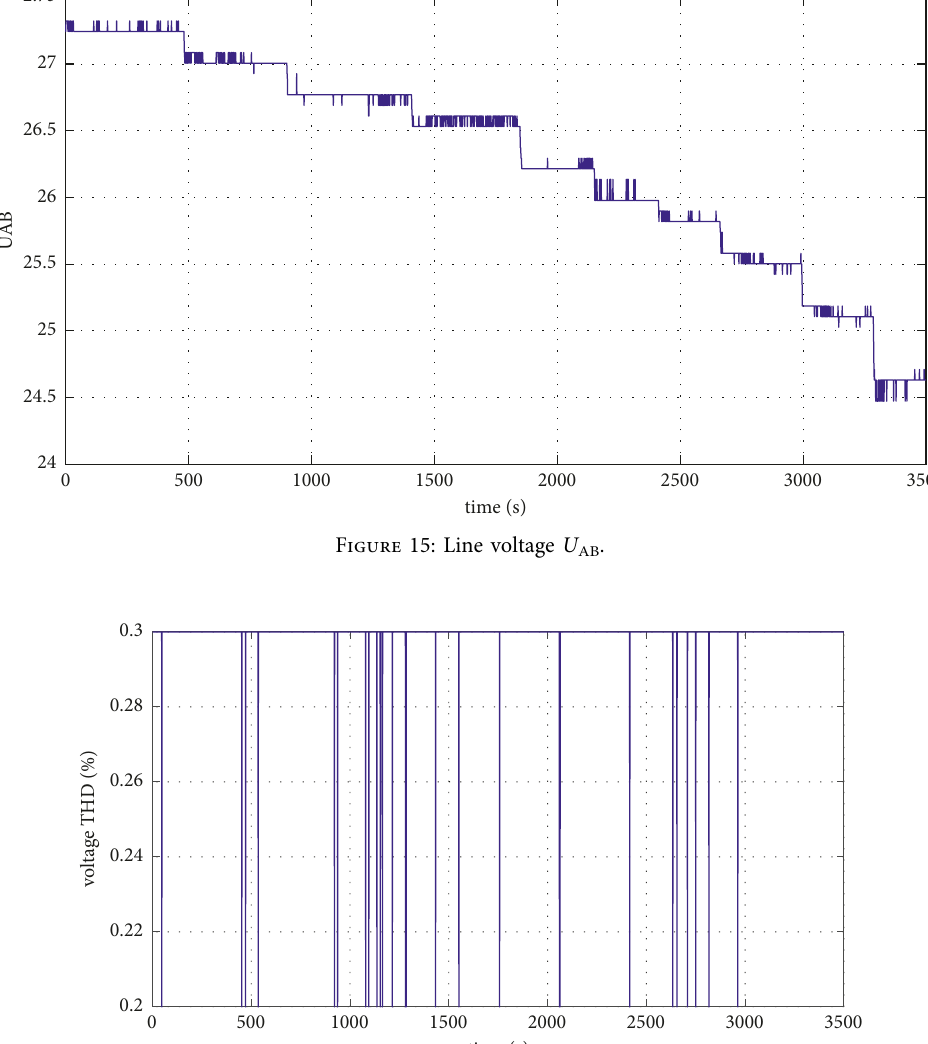
Figure 16: Total harmonic distortion rate (THD) of